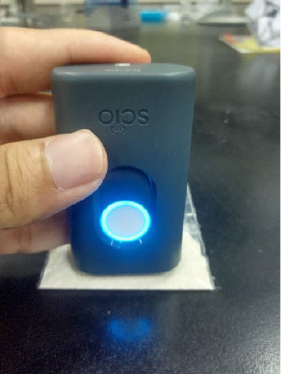
Figure 2. The SCiO TM VIS/SW-NIR sensor spectral data acquisition .